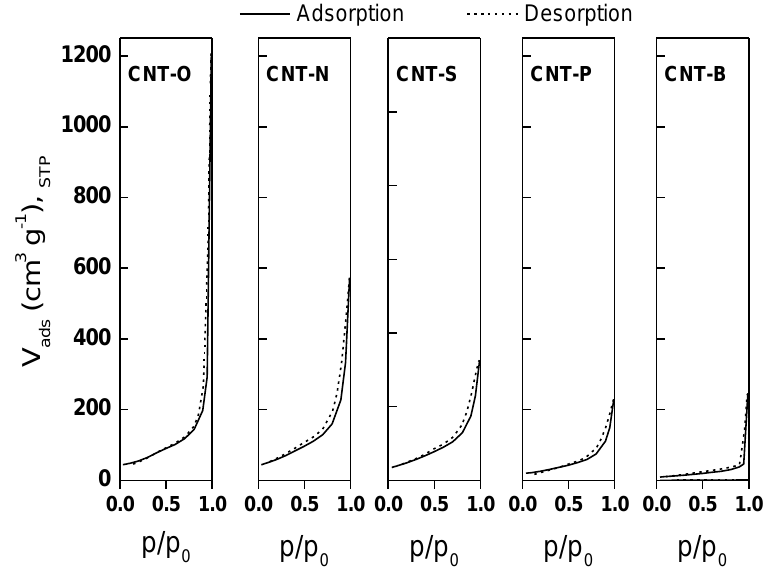
Figure 1. N 2 adsorption—desorption isotherms at −196 °C for carbon nanotube